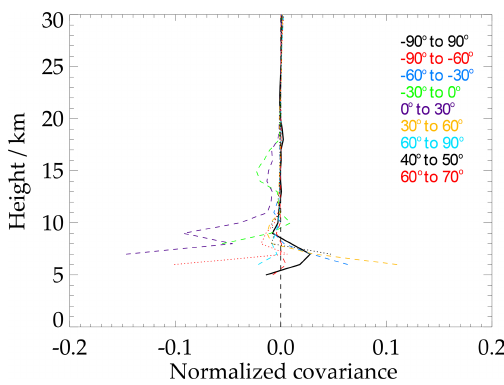
Figure 4. As in Fig 2 but for